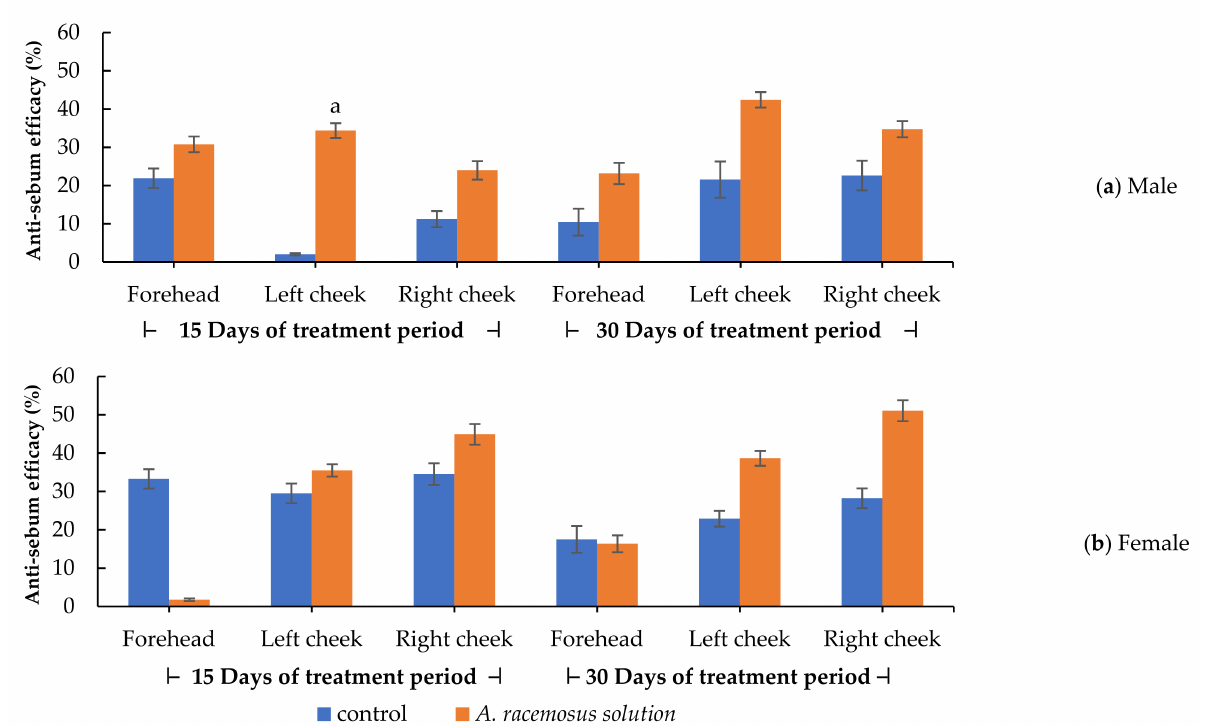
Figure 2. Anti-sebum efficacy of the control (5% of propylene glycol) and the 5% of Asparagus racemosus Willd. root extract solution groups on forehead, left cheek, and right cheek. ( a ) Anti- sebum efficacy on forehead, left cheek, and right cheek in male volunteers after 15 days and 30 days of treatment periods. ( b ) Anti-sebum efficacy on forehead, left cheek, and right cheek in female volunteers after 15 days and 30 days of treatment periods. Statistical significance in comparison to the control is indicated as “a” ( p <